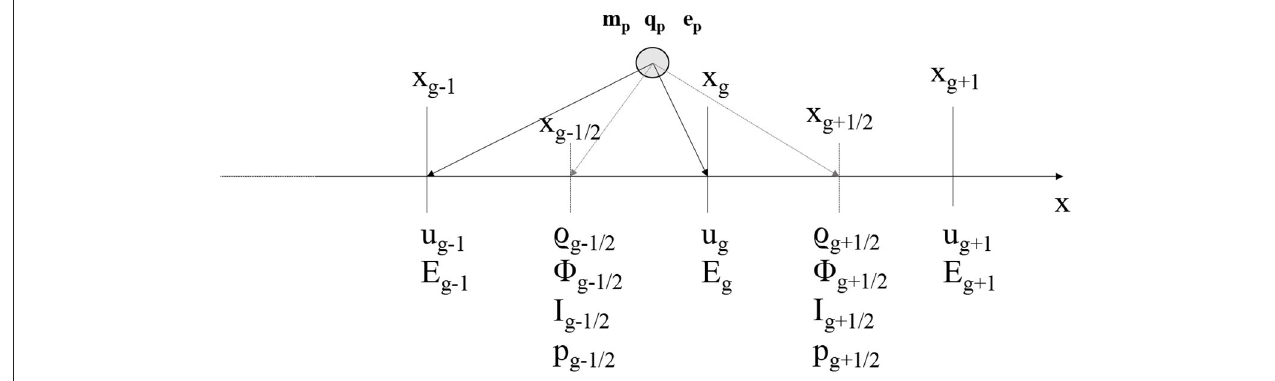
FIGURE 1 | Spatial discretization of PolyPIC